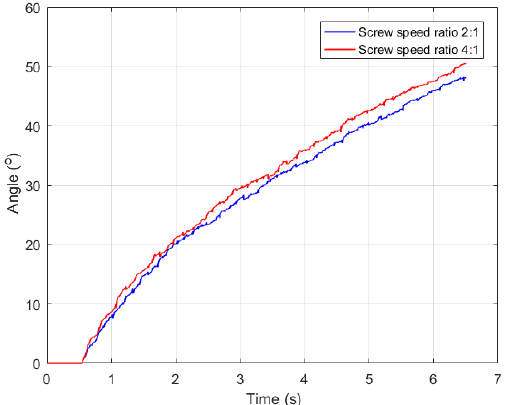
Figure 25. Steering angles of detector at different screw speed ra-